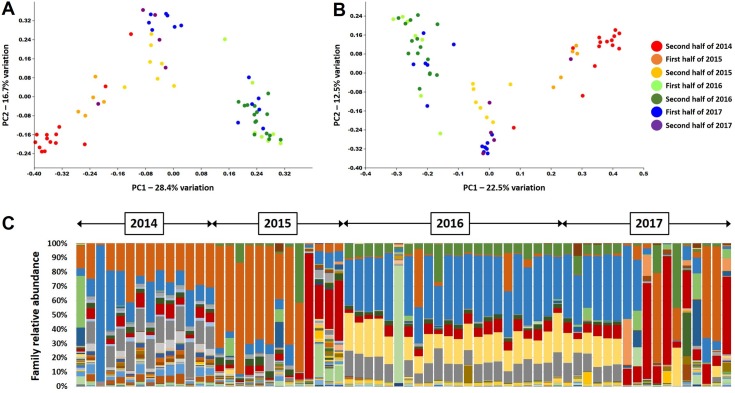
Principal coordinate analysis generated using either Jaccard (A) or Bray-Curtis (B) similarities, showing similarity of the microbial communities detected in bronchoalveolar lavage fluid from dogs diagnosed with chronic respiratory disease (both CB and non-CB, n = 66), colored according to the 6-month period in which they were collected (legend at right). (C) Stacked bar chart showing the relative abundance of families detected in those samples, in temporal order; double-headed arrows above chart denote years.